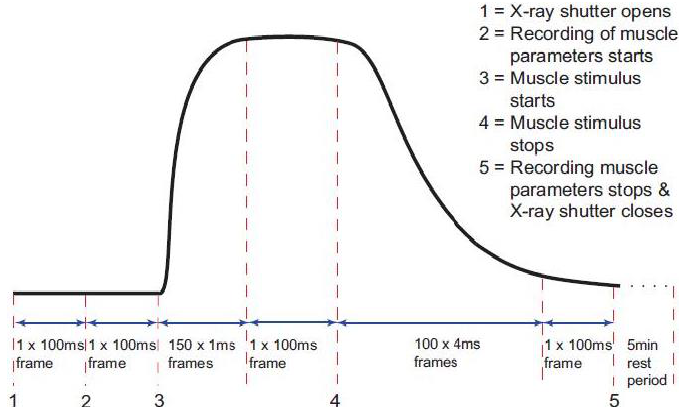
Figure 1. Diagram of the timing protocol used for time-resolved X-ray diffraction experiments. Black trace: a diagrammatic representation of the tetanic tension record produced by an isometrically contracting muscle showing the exposure times for the X-ray diffraction patterns taken throughout the contraction (red dashed lines). The numbers 1 to 5 indicate points where an action occurs as in the top right hand corner of the figure. X-ray data and ionisation chamber readings were recorded throughout. The other muscle parameters such as the muscle tension, change in length and sarcomere length (SL) were only recorded between 2 and 5.